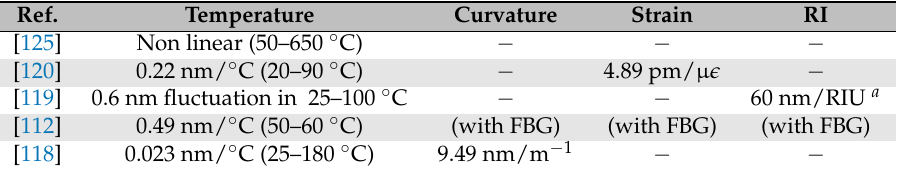
Figure 9. ( a ) Schematic of cladding waveguide Mach–Zehnder interferometer (CWGMZI). ( b ) Different MZI spectra inscribed with the multi-scan technique with different number of scans [122]. ( c ) Spectra of an MZI bent with different curvatures. The spectra exhibit a red shift [118]. Table 3. Measured parameters with CWGMZIs in